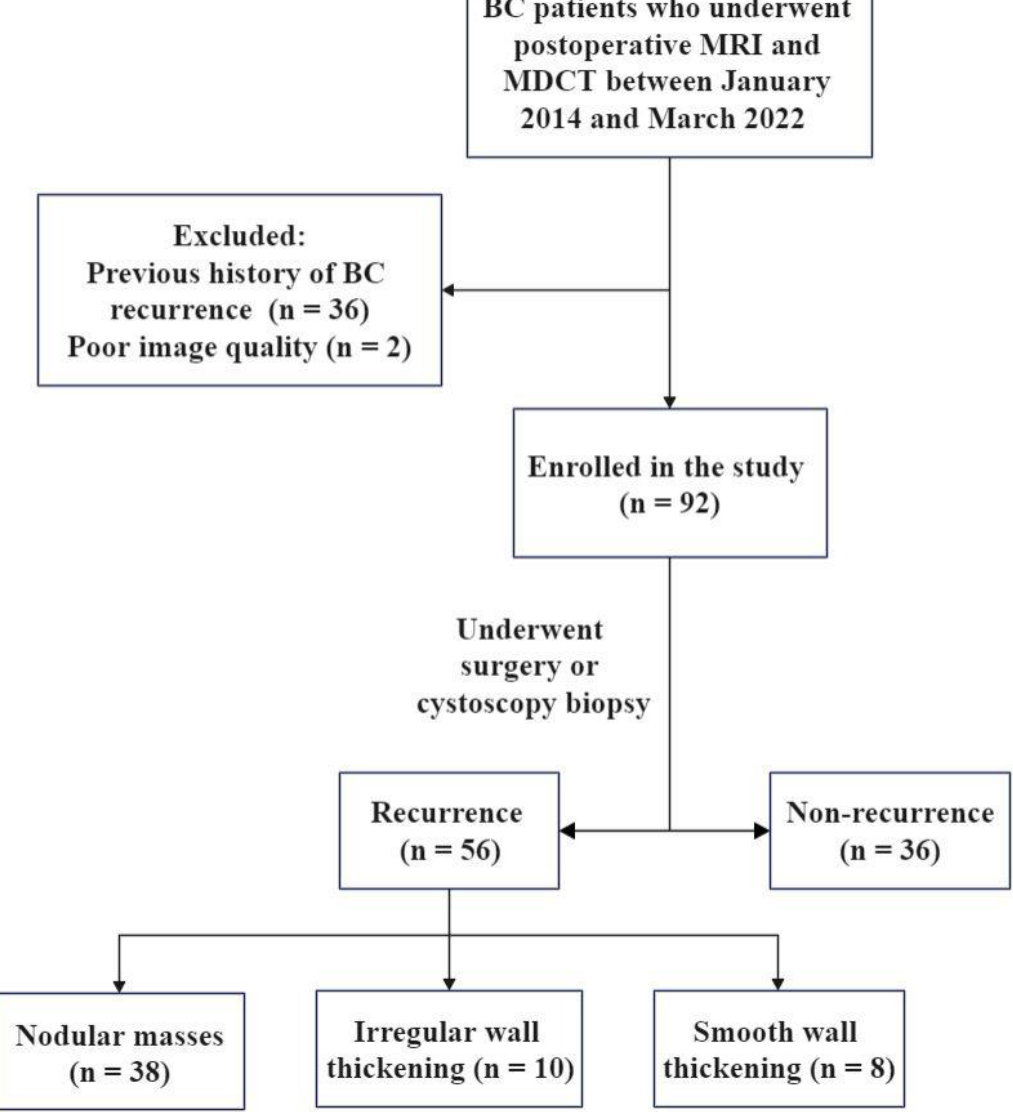
Figure 1. The flowchart of study design. BC, bladder cancer; MDCT, multidetector computed to- mography.